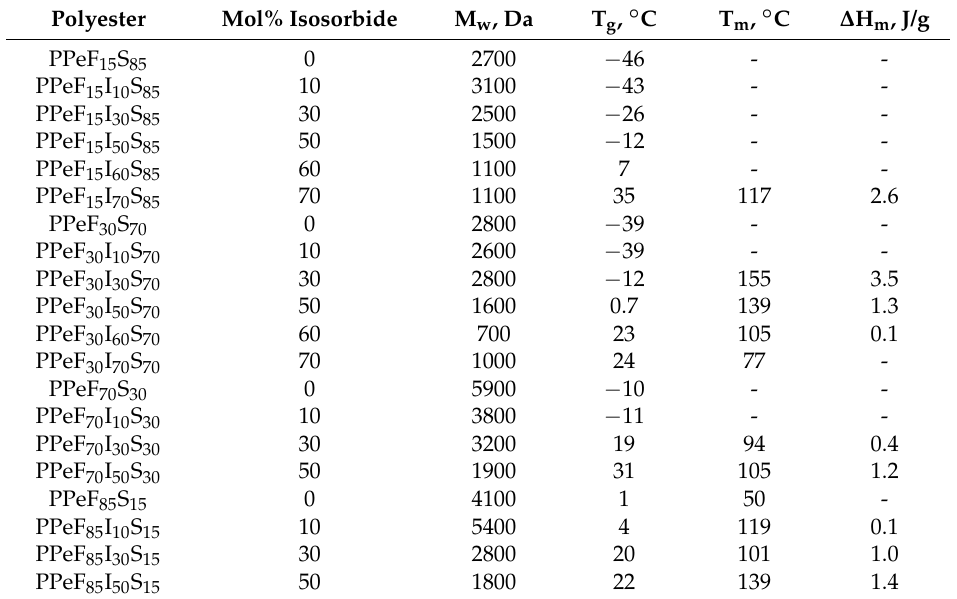
Table 4. Thermal transitions of PPeFIS polyesters measured by differential scanning calorimetry (DSC). Polyester Mol% Isosorbide M w , Da